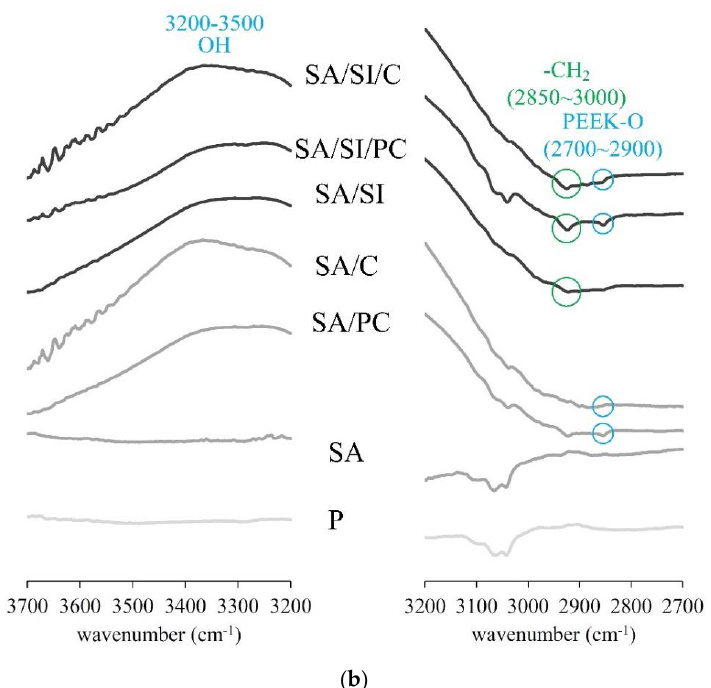
Figure 6. FTIR spectrum of different surface-modified PEEK under ( a ) approximately fingerprint absorption zone and ( b ) specific functional group absorption zone.